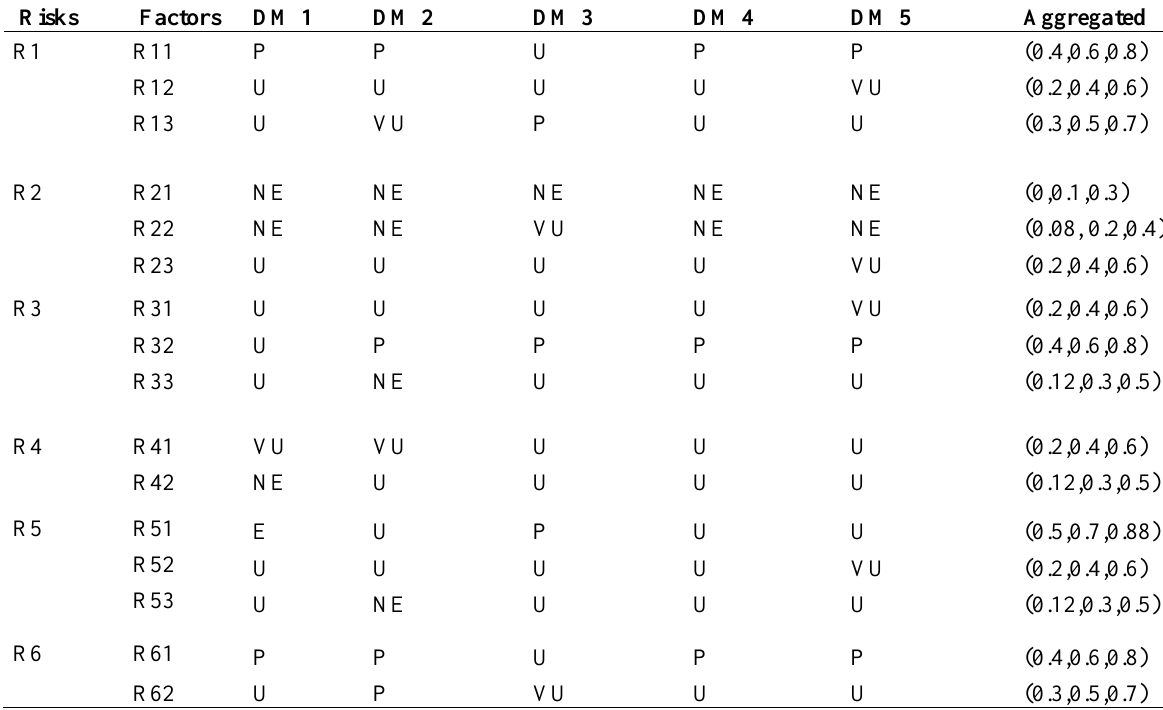
Table 4. The aggregated fuzzy probabilistic values for the probability of the occurrence of each risk event. Risks